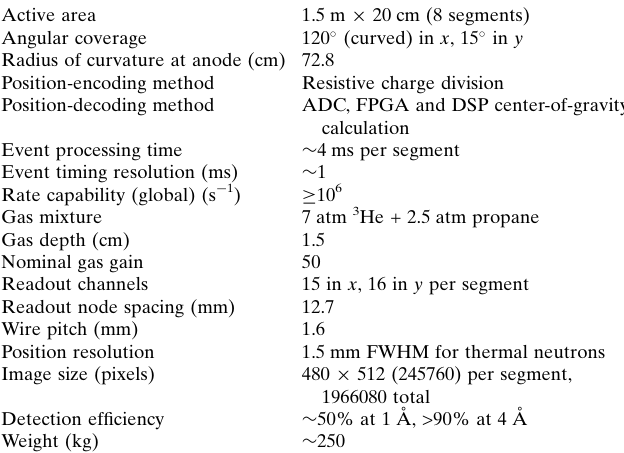
Table 3 Detector specifications. Source: Brookhaven National